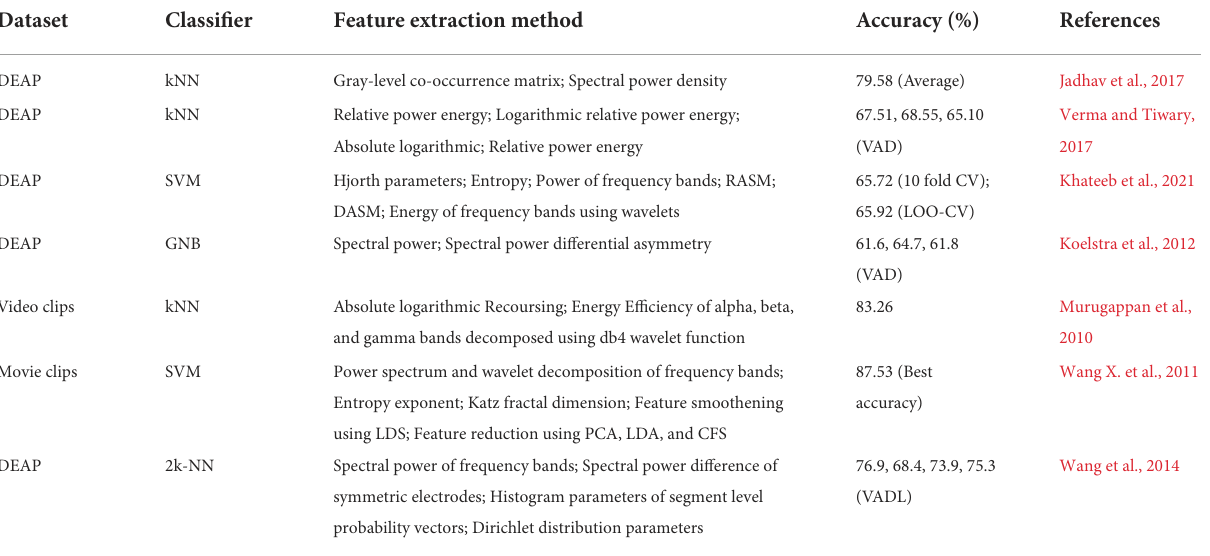
TABLE 1 Table summarizing various machine learning algorithms and features used to classify emotions on various datasets, reported with accuracy. Dataset